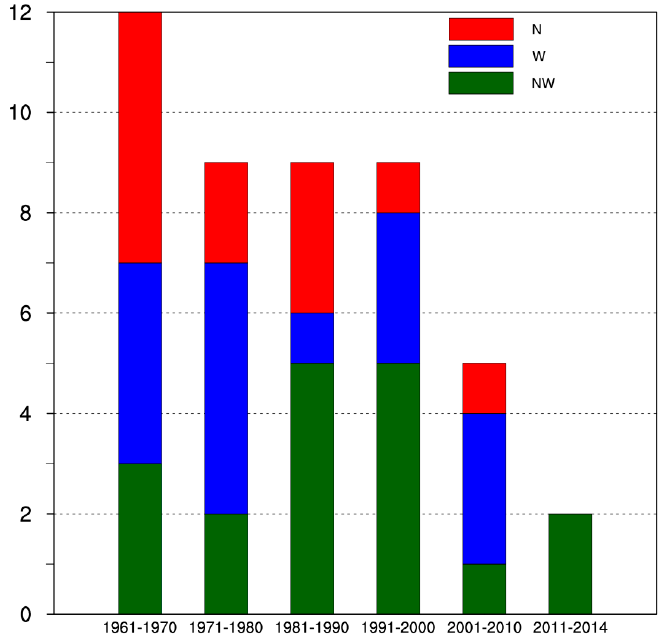
Figure 6. Variability in autumn cold surge occurrences in North China from the north (N), northwest (NW), and west (W) paths.